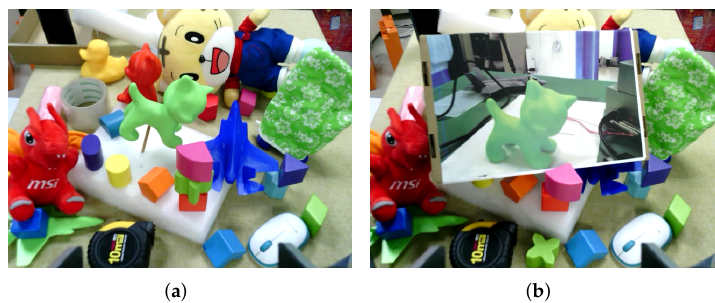
Figure 3. The real object and its photo in the same scene. ( a ) A real object in the scene; ( b ) a photo of the real